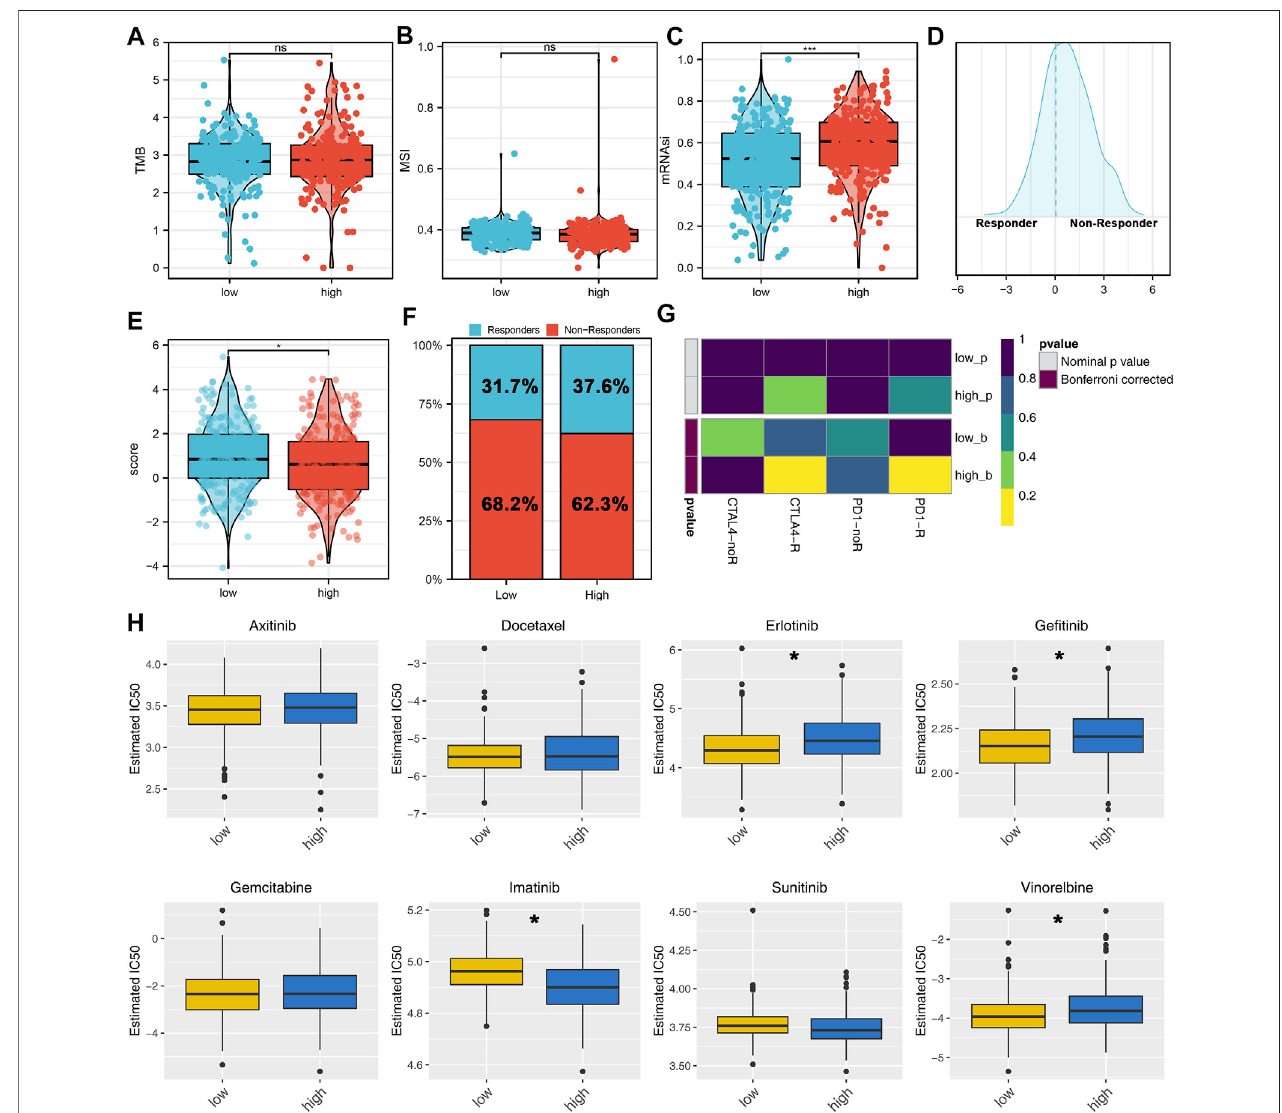
FIGURE 7 | Immunotherapy and drug sensitivity analysis. (A – C) TMB, MSI, and mRNAsi differences between high- and low-risk patients; (D) TIDE analysis was performed to evaluate the immunotherapy response of patients, among which TIDE > 0 was de fi ned as non-responders and < 0 was de fi ned as responders; (E) DifferenceofTIDEscorebetweenthehigh-andlow-riskgroups; (F) High-riskgrouphadahigherpercentage ofimmunotherapyresponders; (G) Submapalgorithmwas performed to explore the speci fi c immunotherapy options; (H) Chemosensitivity difference between the high- and low-risk patients.